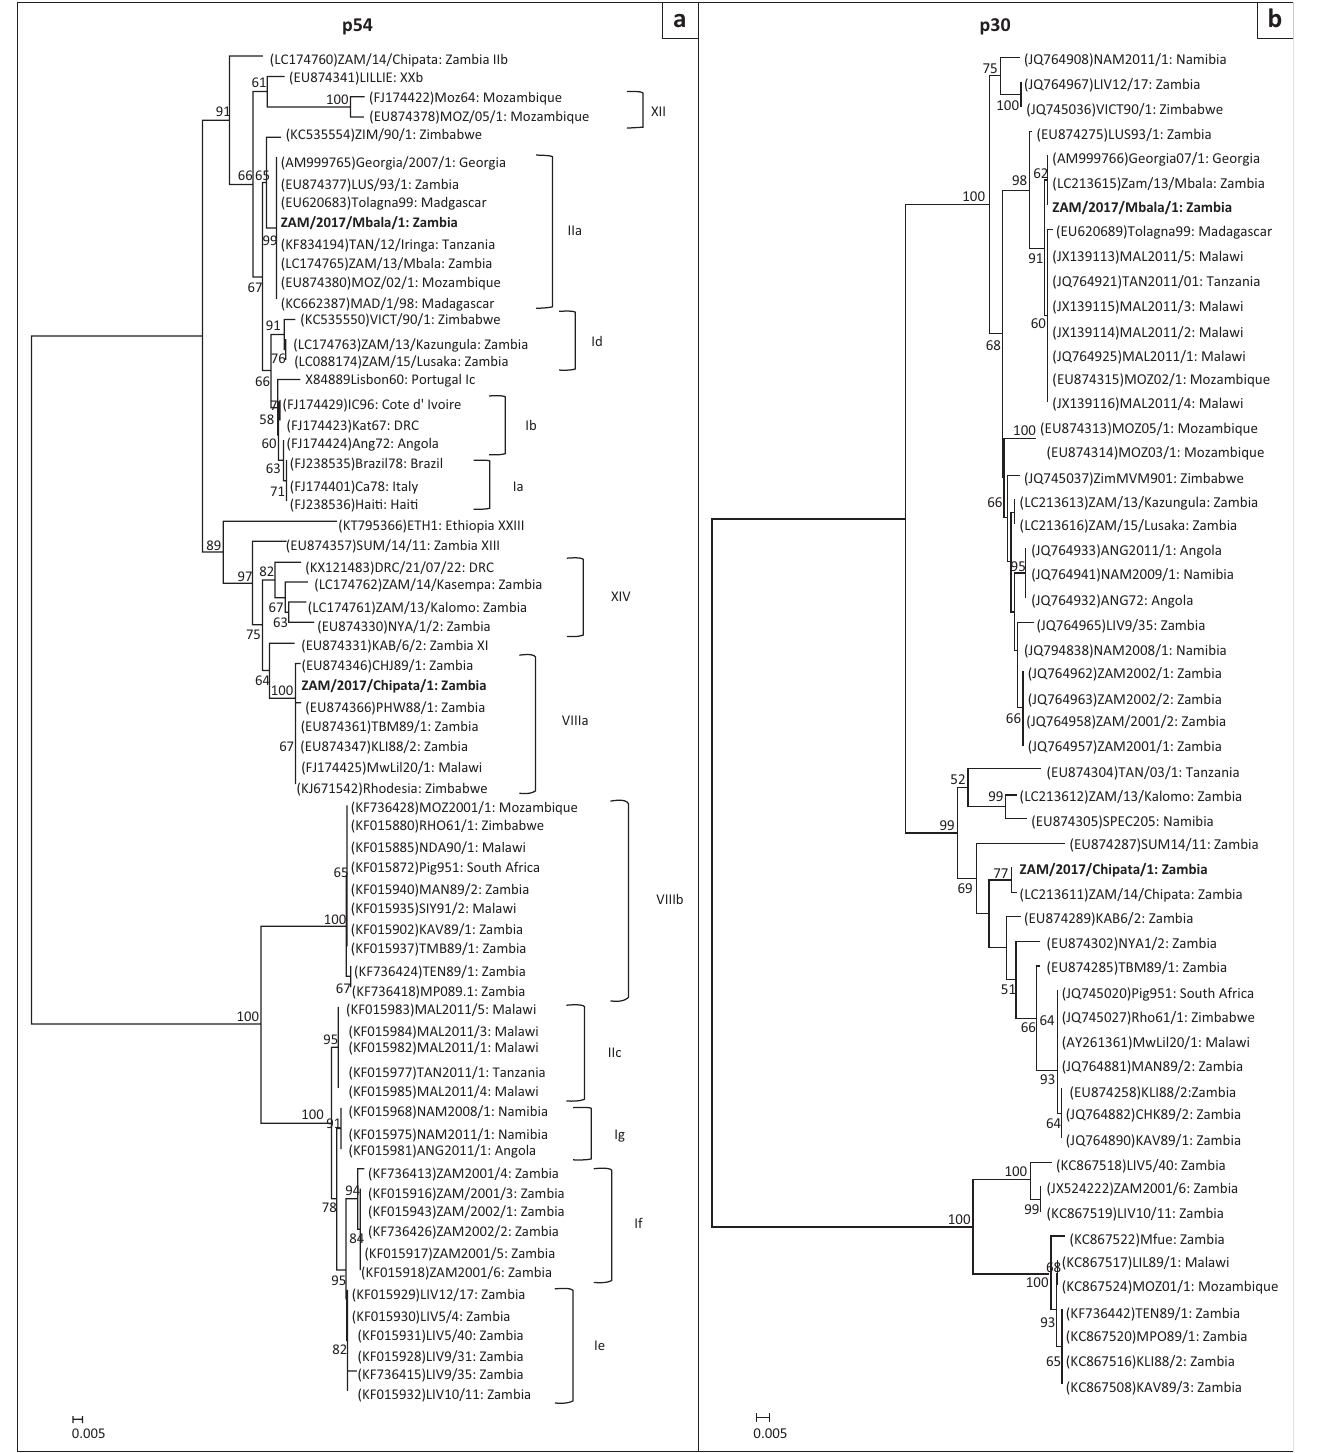
FIGURE 2: Phylogenetic relationships of the p54 (a) and p30 (b) genes of African swine fever viruses detected in domestic pigs during 2017 in Zambia. The evolutionary relationships were conducted by MEGA6 software using the neighbour-joining method, with evolutionary distances being computed by the p -distance method. Numbers at branch nodes indicate bootstrap values ≥ 50 % . The GenBank accession numbers of strains included in the analyses are indicated in parenthesis and the p54 genotypes are shown after the country of origin of the strains or the right bracket. Virus strains characterised in this study are in bold. Bar, number of substitutions per